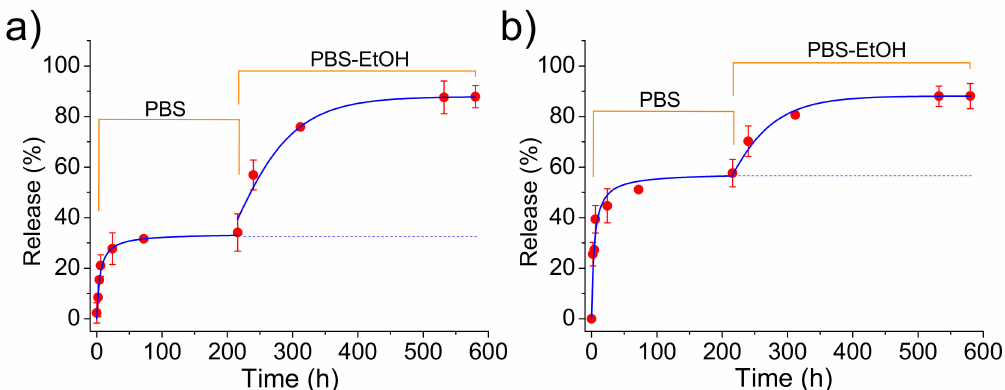
Figure 11. Release of CAM from PLA electrospun microfibers loaded with ACP-CAM ( a ) and cHAp-CAM nanoparticles ( b ) during exposure to the indicated media. PBS-EtOH refers to the PBS-ethanol mixture (see Methods